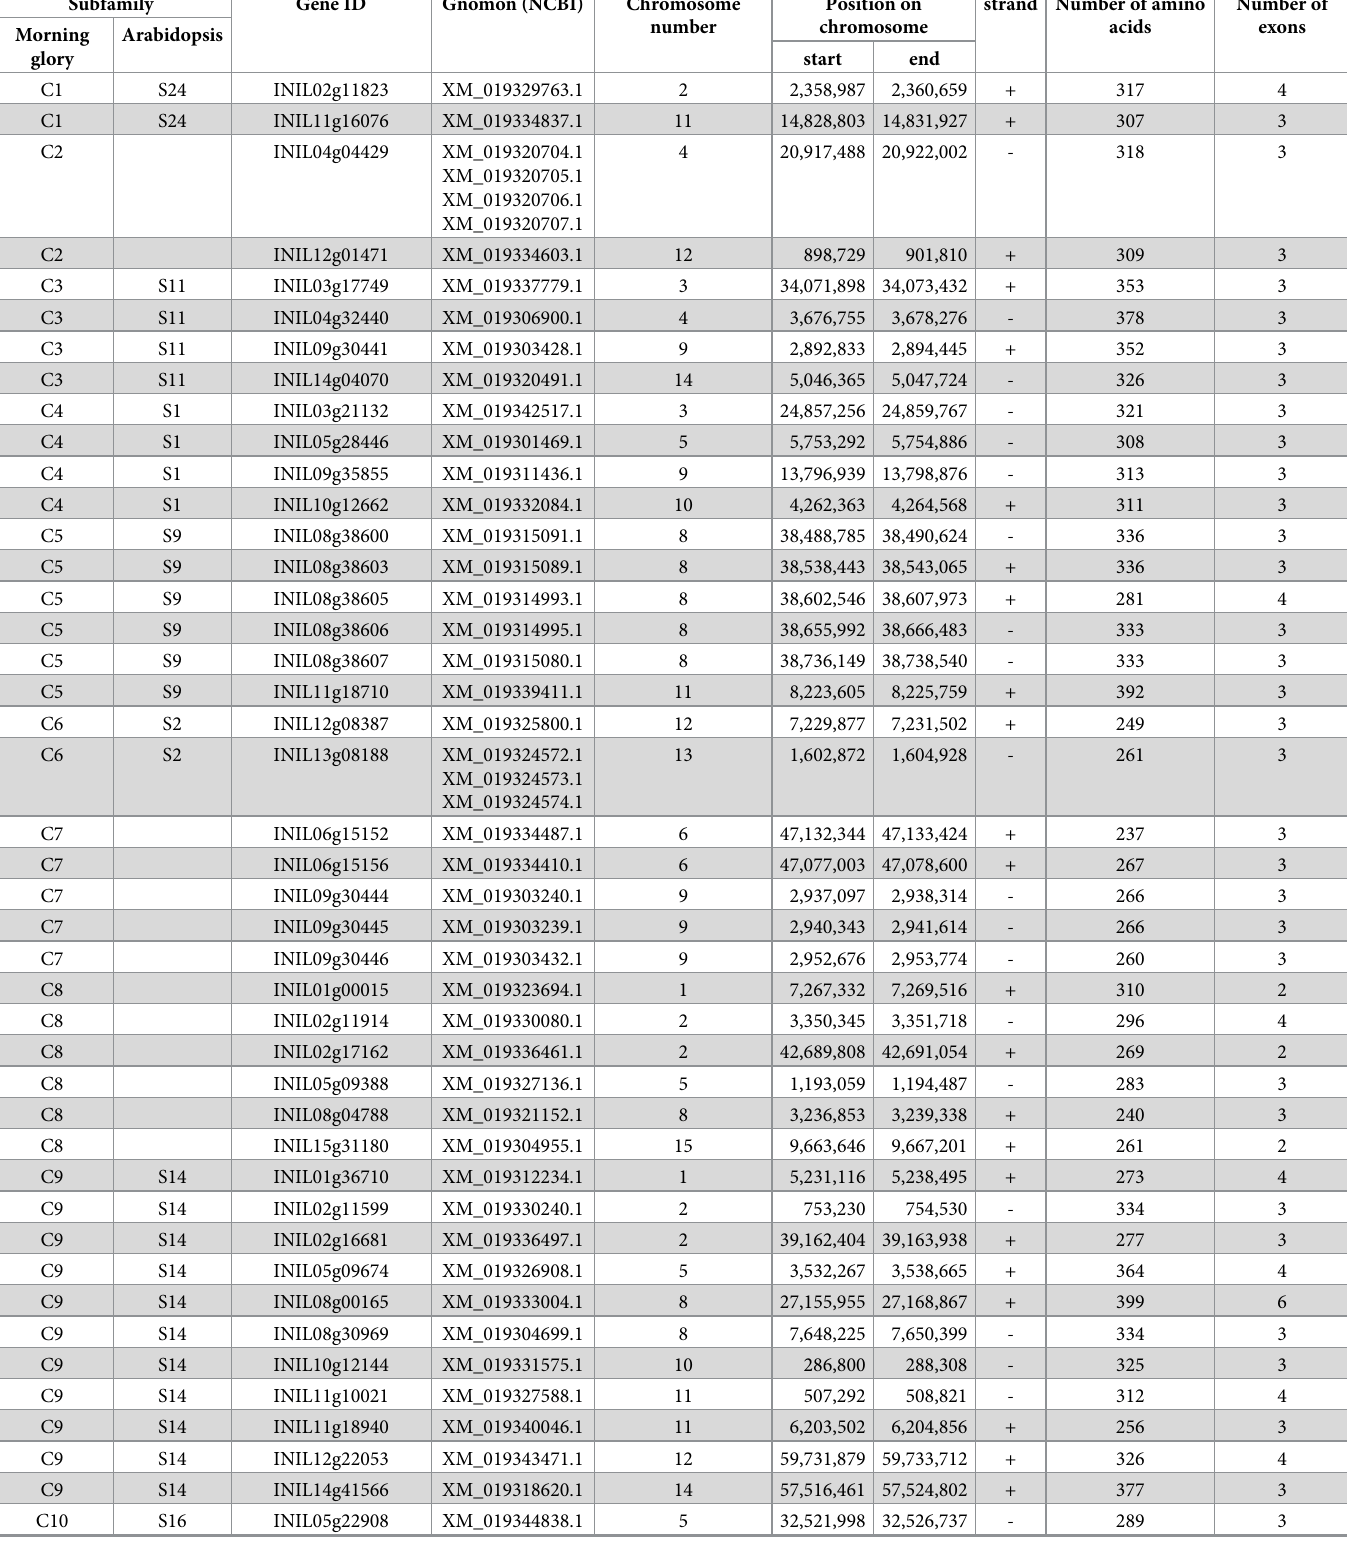
Table 1. The list of the R2R3-MYBs identified in the genome of Japanese morning